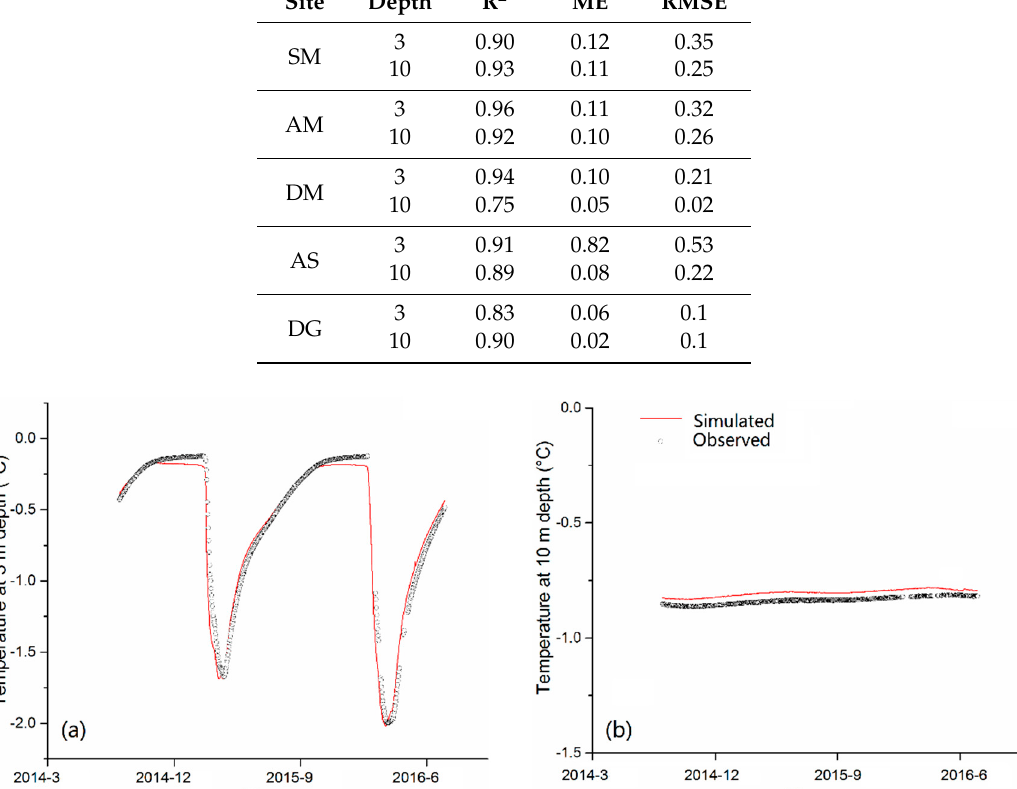
Figure 3. Comparison of the simulated and observed ground temperature at ( a ) 3.0 m depth, and ( b ) 10.0 m depth for site AM.